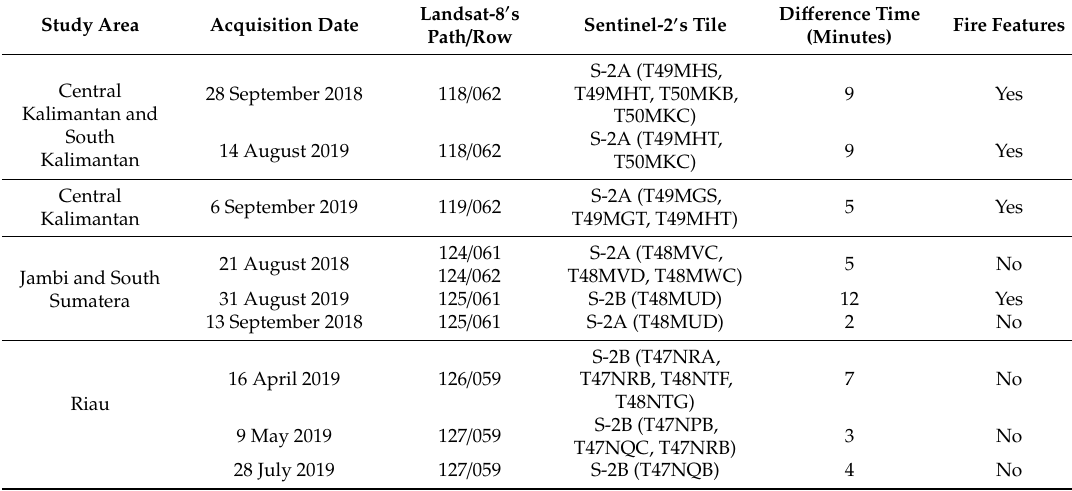
Table 4. List of Landsat-8 and Sentinel-2 data for applying and assessing application of ToPeCAl-2 to images over Central Kalimantan, South Kalimantan, West Kalimantan, Riau, Jambi, and South Sumatera. There are four pairs of Landsat-8 and Sentinel-2 images contained fires in the same areas on the day of acquisition. Descending orbit Landsat-8 images were acquired at 2–12 min after Sentinel-2 image acquisition. The state of fire features was identified from the Red-Green-Blue (RGB) image composites of SWIR-2, SWIR-1, and Red bands of Sentinel-2 and Landsat-8